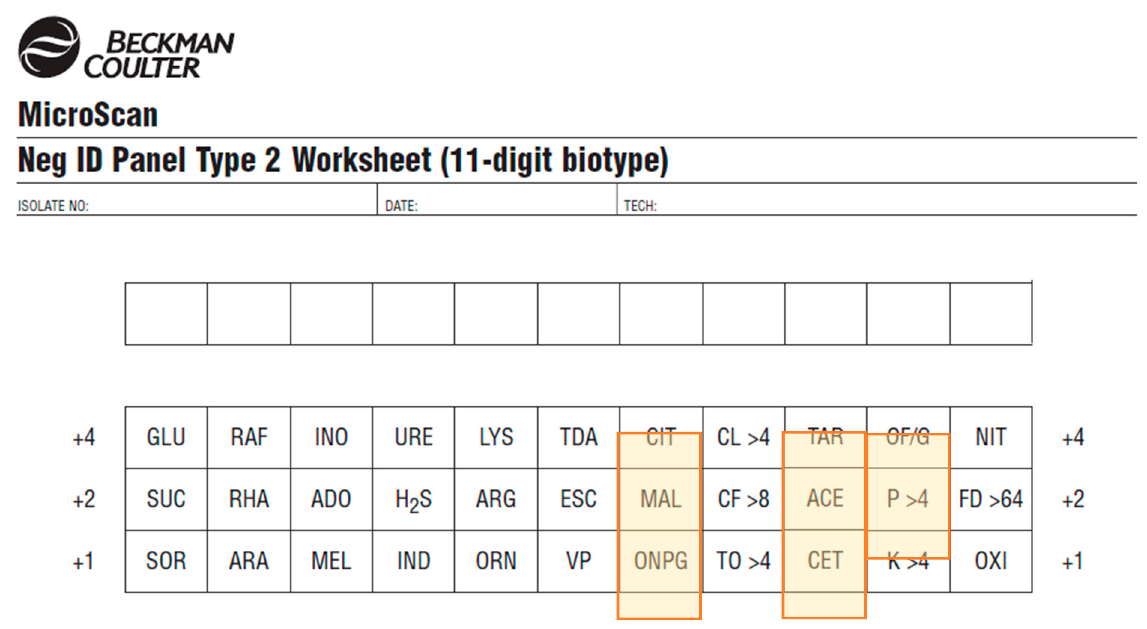
Figure 5. Worksheet for the NID2 panel. Tests marked in orange are in a different order on the panel than they are on the worksheet (see Figure 1). Table 7. Ease-of-use assessment with a focus on use in low resource settings of different aspects of the MicroScan identi- fication panels. Abbreviations: IFU = instructions for use; PEP = peptidase; PYR = pyrrolidonyl-b-naphtylamide; VP = Voges–Proskauer test